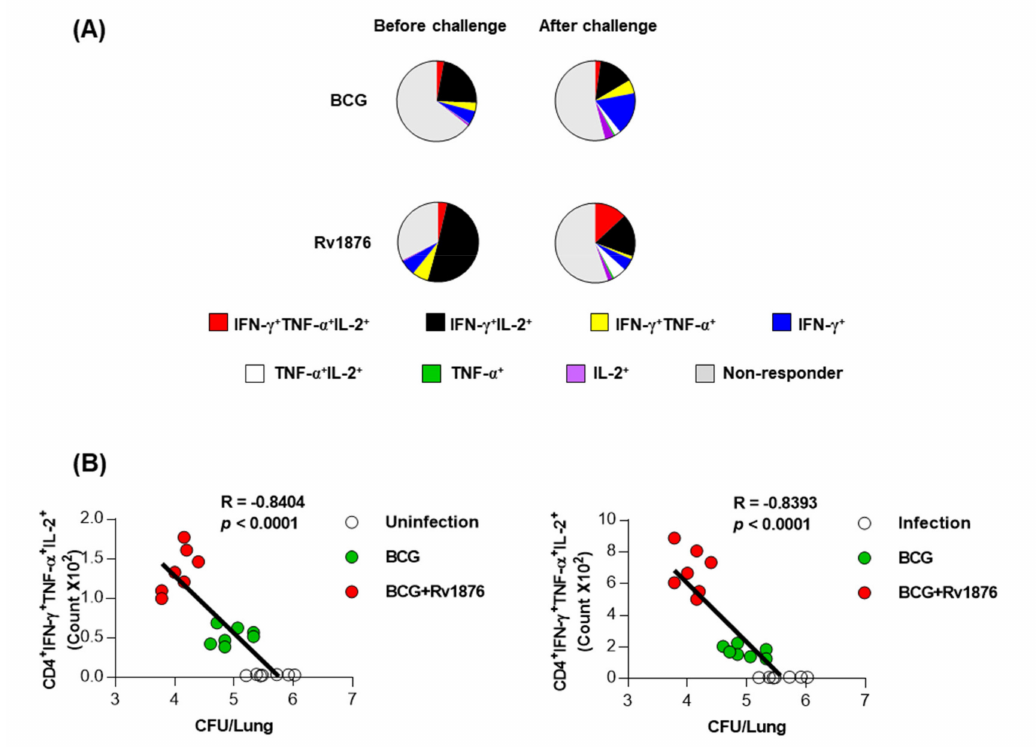
Figure 5. Induction of Ag-specific multifunctional T-cells in the lungs and analysis of protective correlations for protection levels. ( A ) Mice were immunized and euthanized as described in the Methods section. Four weeks after the last immuniza- tion, the mice were sacrificed, and the lung cells collected from the mice were treated with Rv1876 (2 µ g/mL) at 37 ◦ C for 12 h in the presence of GolgiStop. Upon stimulation with Rv1876, cell counts of Ag-specific, multifunctional CD4 + CD44 + T-cells producing IFN- γ , and/or TNF- α and IL-2 in the lung cells from each immunized group were determined by flow cytometry. ( B ) The relationship between protection (CFU) and Rv1876 specific CD4 + CD44 + IFN- γ + TNF- α + IL-2 + producing T cells is shown as a fitted regression line with the correlation coefficient. Spearman’s r and P values of the correlations are indicated. White circle: naïve or infection, green circle: BCG, and red circle: BCG plus